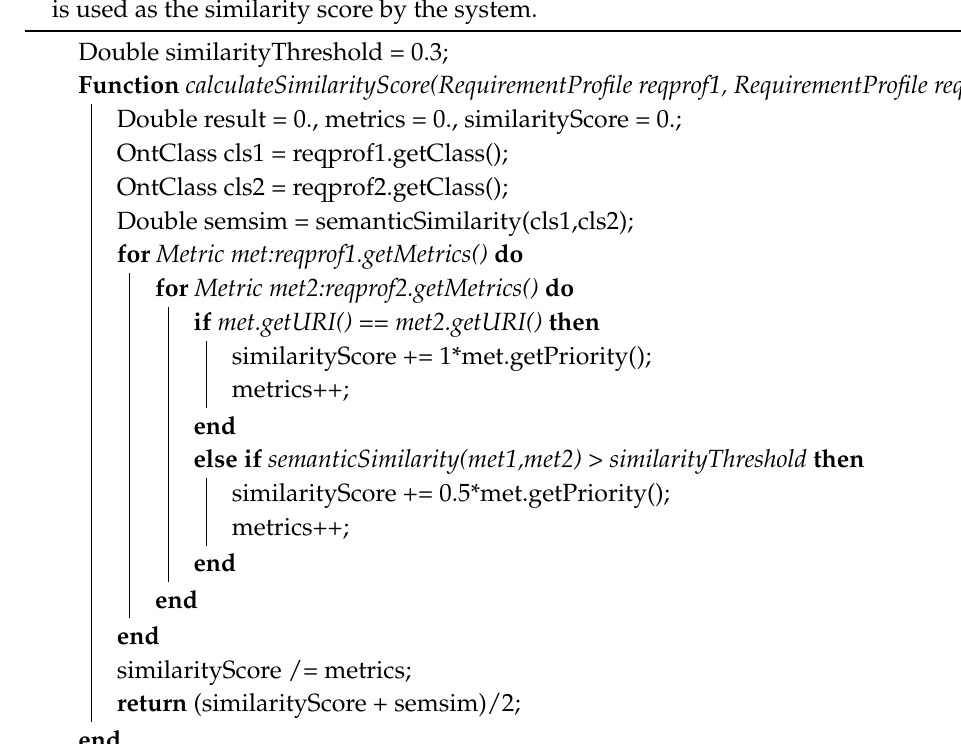
Algorithm 1: Semantic Similarity algorithm: The algorithm consists of the calculation of a semantic similarity using a given metric (semanticSimilarity) which is used to relate single metrics and the class which describes the requirement profile. The aggregated percentage score is used as the similarity score by the